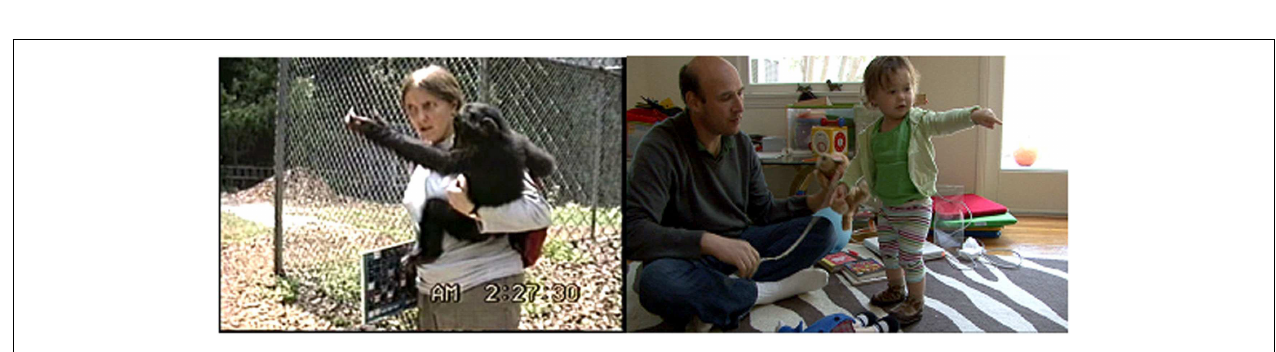
FIGURE 7 | Examples of an up gesture. Up involves raising the arm/arms above the head with the implied intention of being picked up. Left: ape example – Panbanisha climbing on car. Sue, holding Panpanzee on shoulders, says “Panban, don’t do that.” Panbanisha (17months, 26days) gets down and